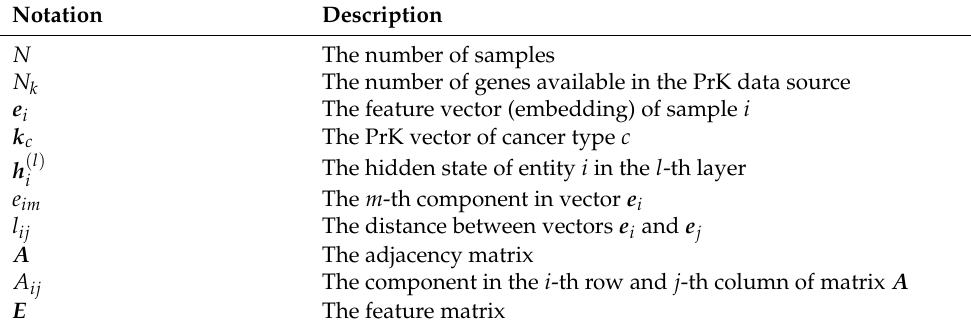
Table 1. List of